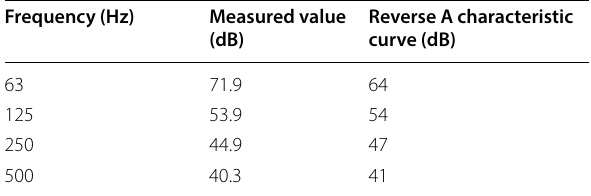
Table 6 Heavyweight floor impact noise data.